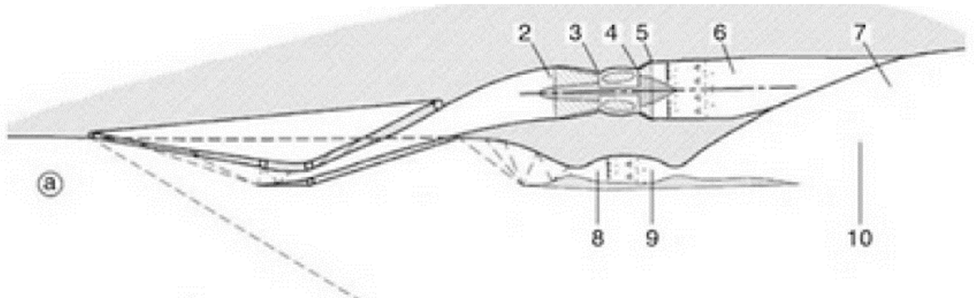
Figure 6. Over-under configuration of a turbojet and ramjet engine.